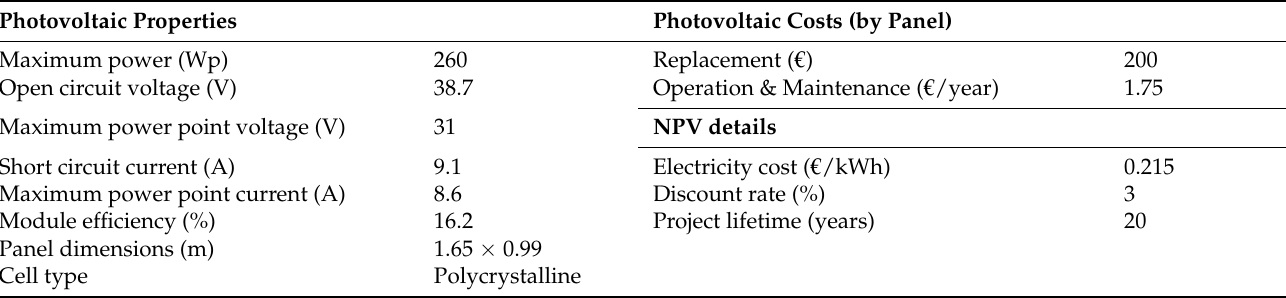
Table 3. Technical specifications of photovoltaic